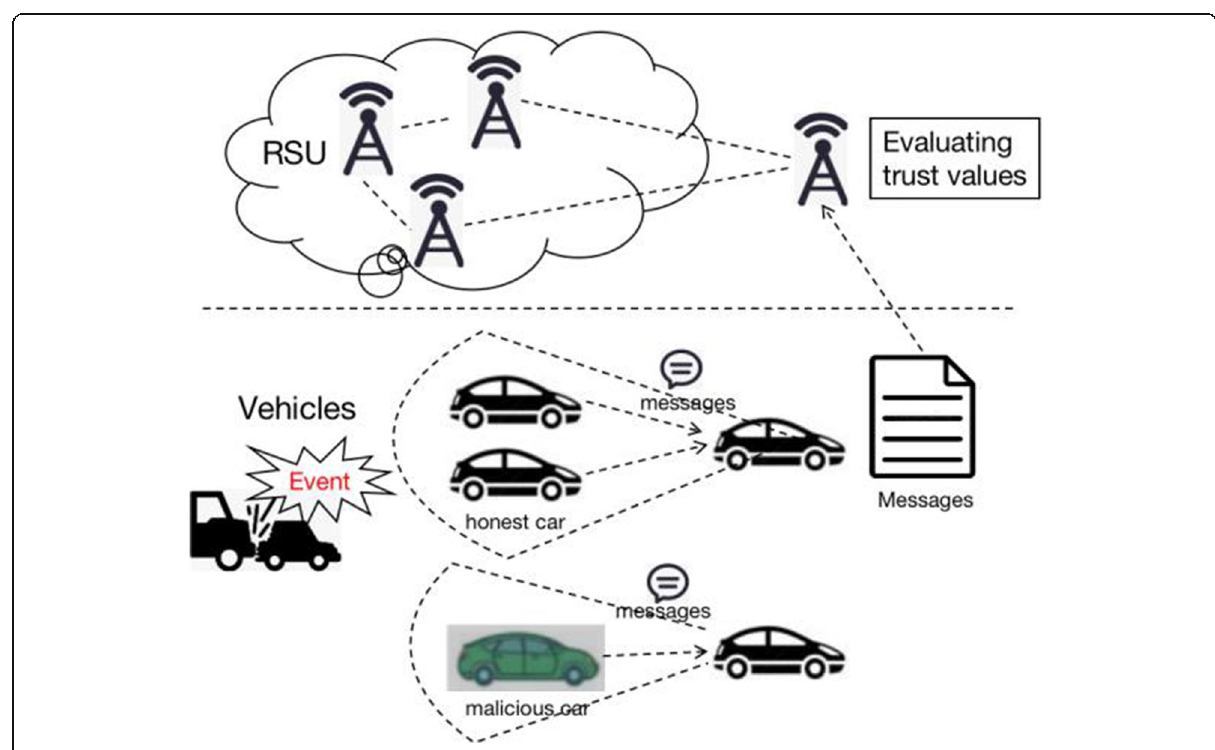
Fig. 17 Blockchain-based trust management model for vehicular networks [89]